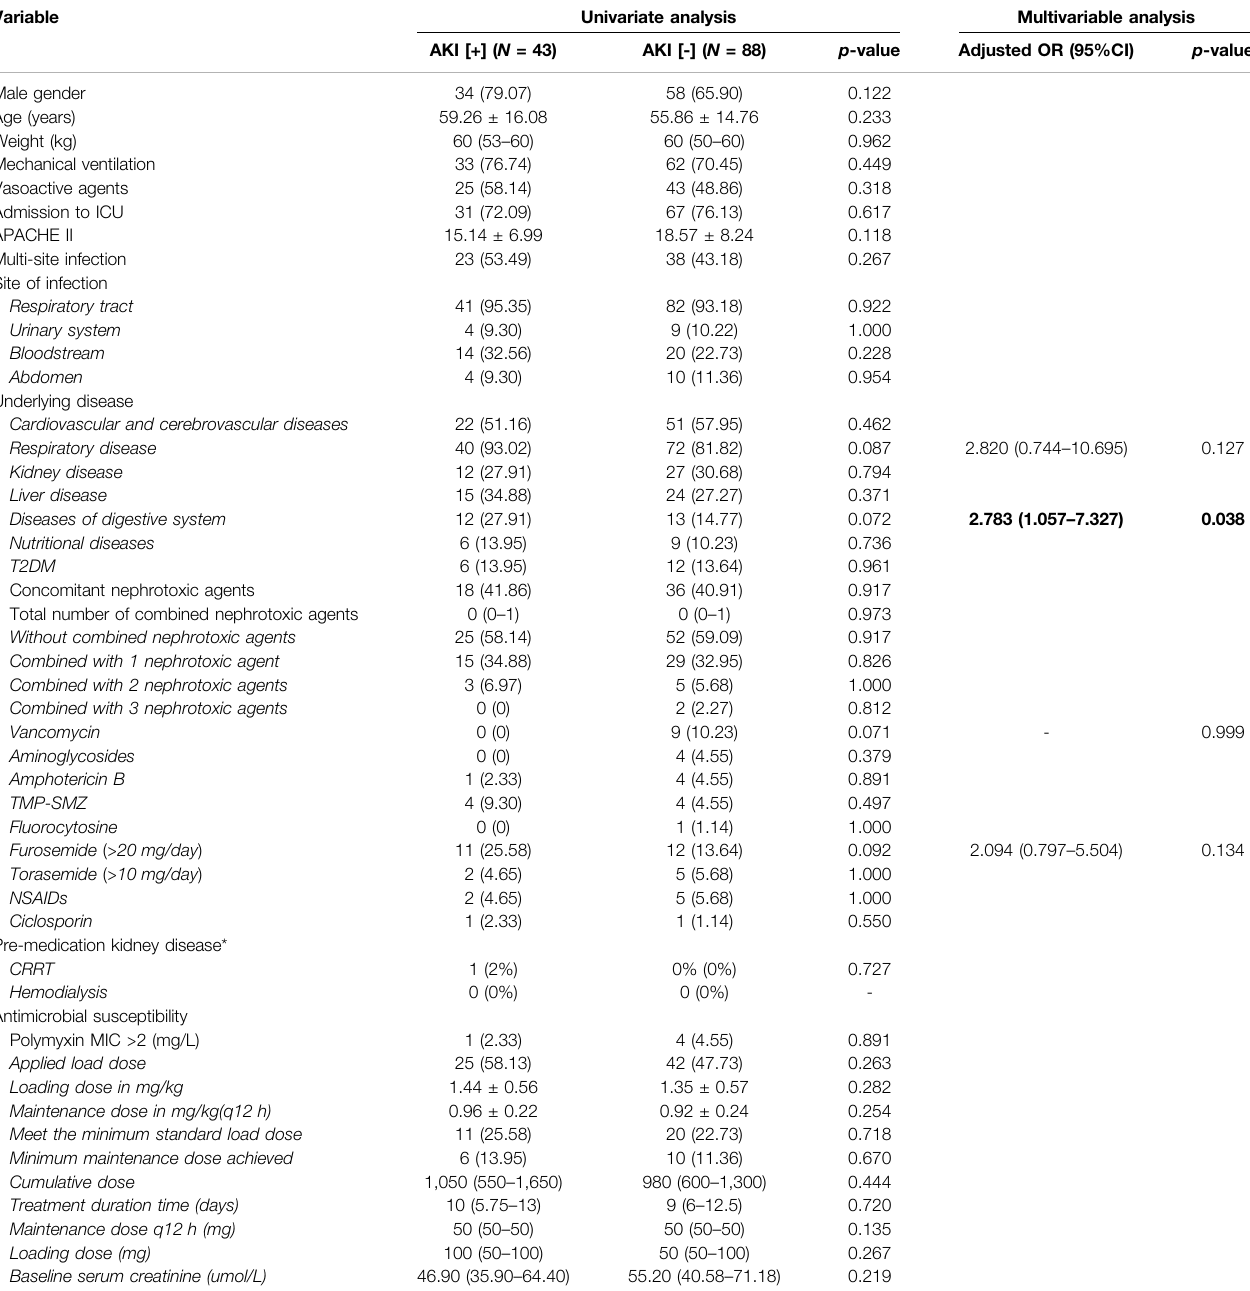
TABLE 3 | Univariate analysis and multivariate logistic regression of patients with normal renal function develop nephrotoxicity after PMB